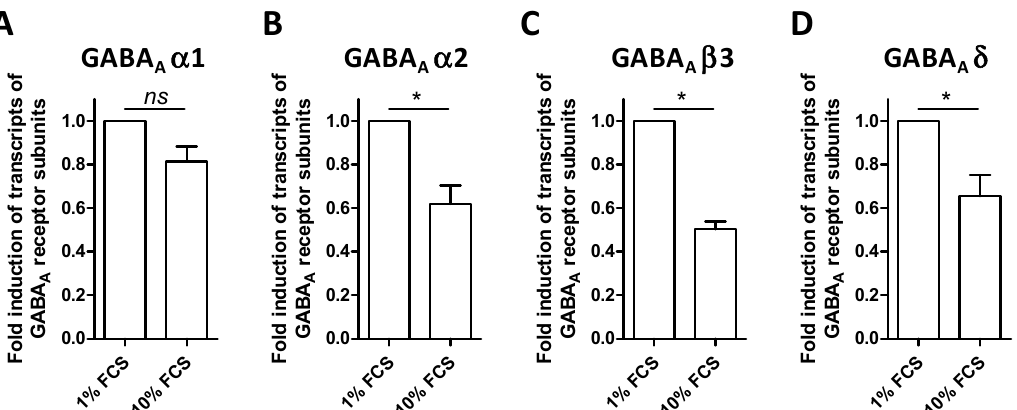
Figure 2. Gene expression of γ -aminobutyric acid-A (GABA-A) receptor subunits in BV-2 cells. Expression level of GABA-A receptor ( A ) α 1, ( B ) α 2, ( C ) β 3, and ( D ) δ subunits in BV-2 cell line are determined by quantitative PCR. The experimental results represent the fold induction of mRNA expressed by BV-2 grown in presence of 10% FCS in comparison to BV-2 grown with 1% FCS after normalization to Ppia expression. Mean values ± SEM are shown, from n = 4 independent experiments, * p < 0.05.